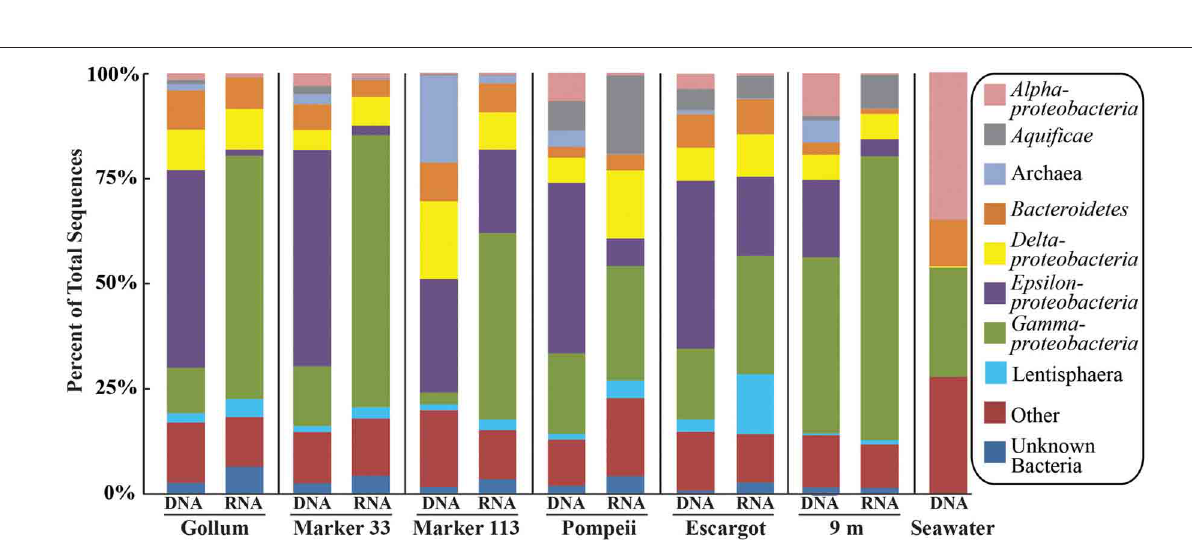
( Figure 7 ). Comparison of RNA and DNA profiles of the most abundant OTUs for Gammaproteobacteria shows high activity of Gammaproteobacteri a in most vent fluids. Out of 67 Gammaproteobacteria OTUs considered, 56 were scored as active ( Table 4